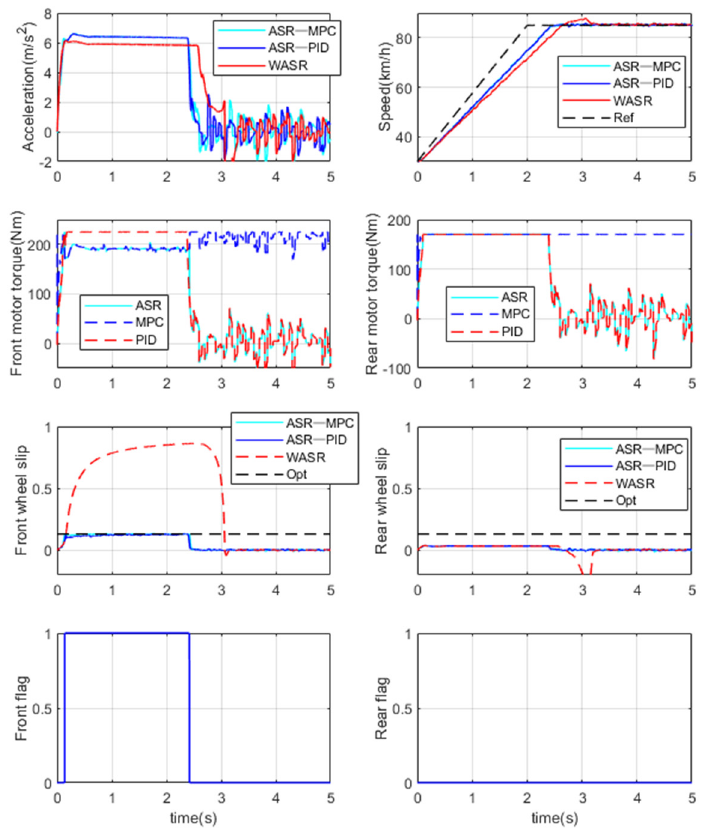
Figure 9. Vehicle accelerates under a high adhesion coefficient road.